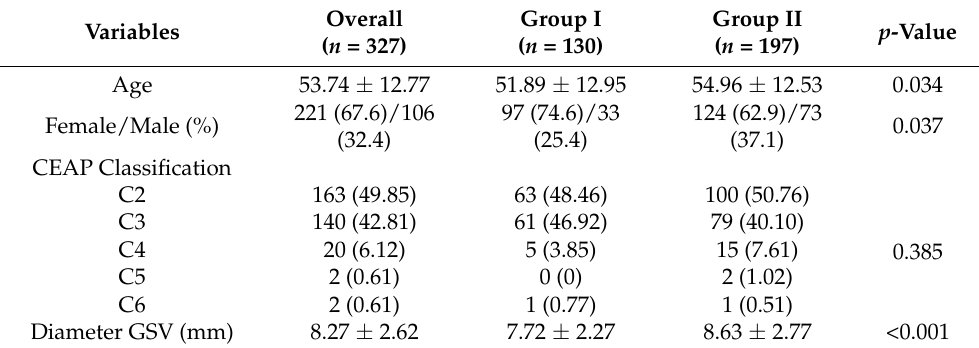
Table 1. Clinical characteristics between MOCA (Group I) and combined EVLA and MOCA (Group II). Overall Variables